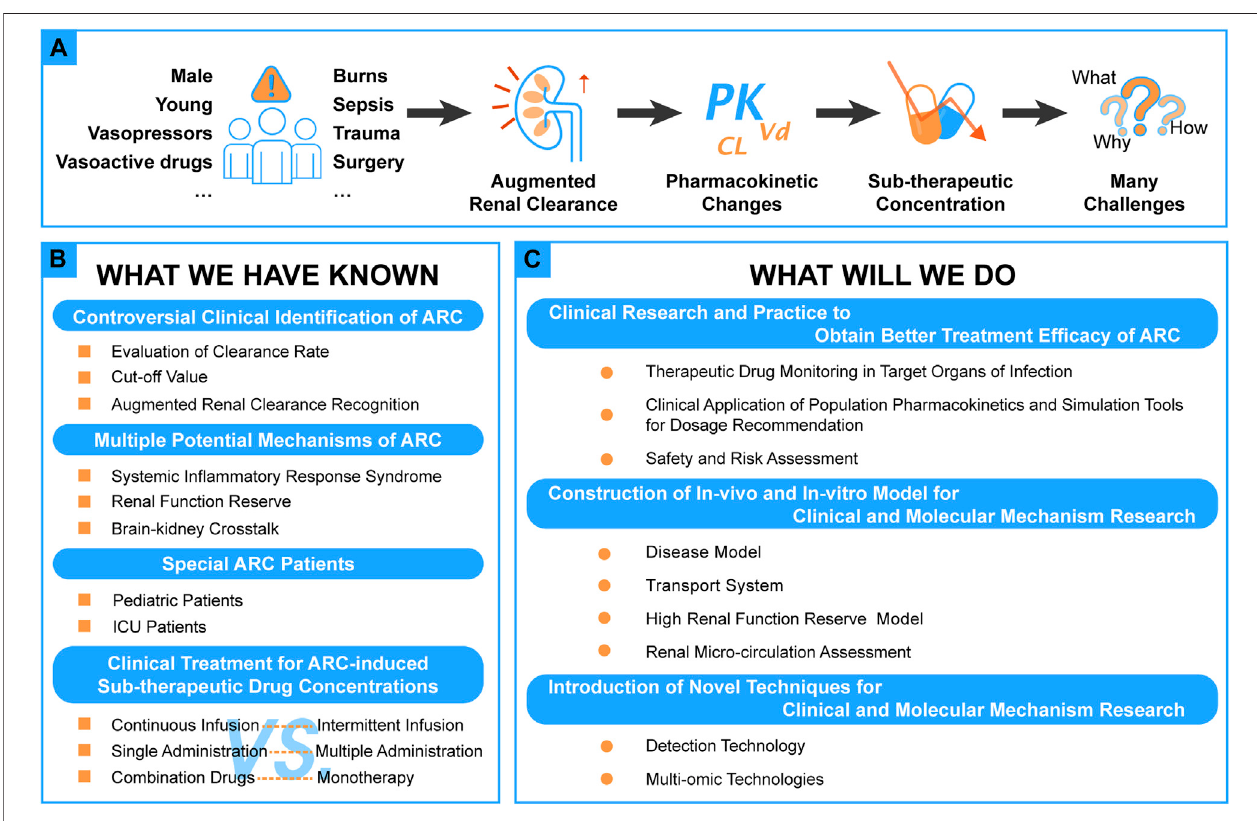
FIGURE 1 | A schematic diagram of main content of this